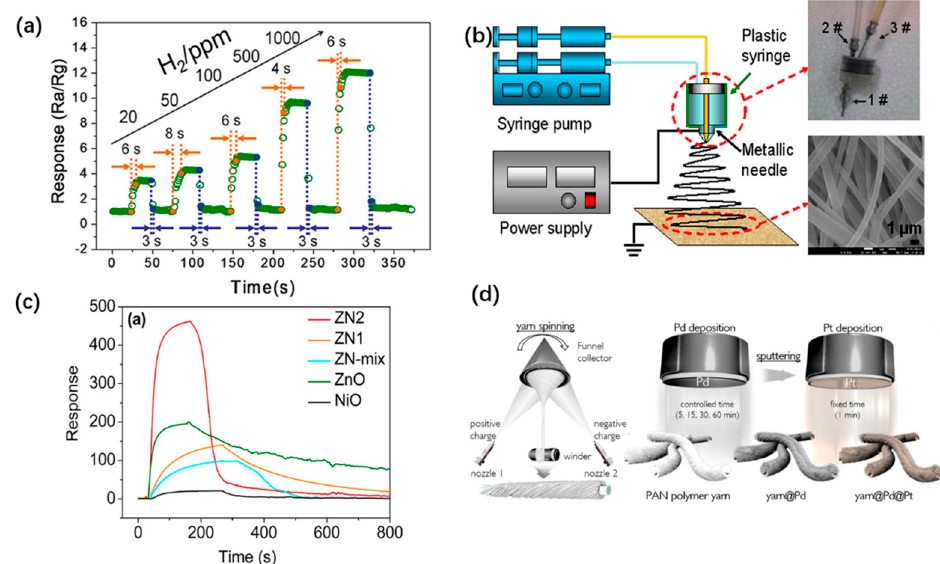
Figure 3. Fabrication of alloy/metal oxide (MO) interfaces: ( a ) Dynamic H 2 sensing transients of all sensors with different loading levels at % to 20, 50, 100, 500, and 1000 ppm in turn [77], copyright 2017 MDPI; ( b ) schematic diagram of the experimental blending method setup. The insets are the actual photo of the coaxial dual spinnerets (the top one) and the SEM image of the precursor nanofibers (the below one); ( c ) response transients of different gas sensors to 20 ppm H 2 S at 215 °C [78], copyright 2012 American Chemical Society; ( d ) the synthesis of the yarn/Pd and yarn/Pd/Pt via yarn spinning followed by a sputter-deposition process, copyright [79] 2019 American Chemical Society.